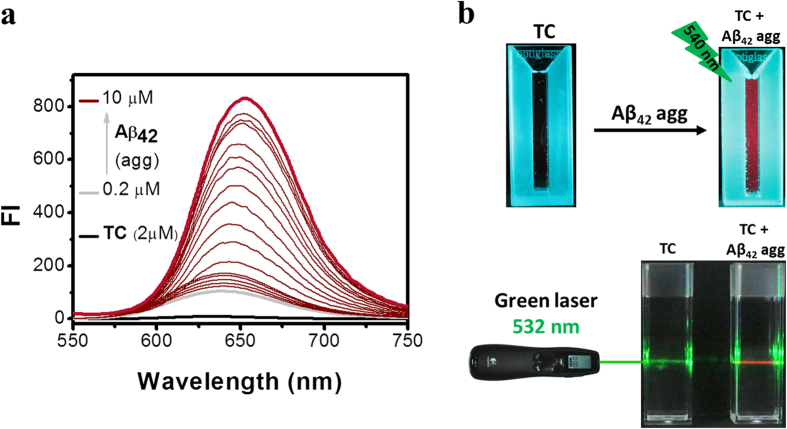
(a) Emission (FI) spectra (λex = 537 nm) of probe TC (2 μM) with increasing concentration of Aβ42 fibrils (0.2, 0.4, 0.6, 0.8, 1.0, 1.2, 1.4, 1.6, 1.8, 2.0, 2.5, 3.0, 3.5, 4.0, 4.5, 5.0, 6.0, 7.0 and 10.0 μM). (b) Photographs of TC and TC (2 μM) + Aβ42 (15 μM) fibrils samples illuminated under green light (540 nm), TC (2 μM) + Aβ42 (15 μM) illuminated with laser emitting green light (532 nm) shows a red beam in the sample solution.